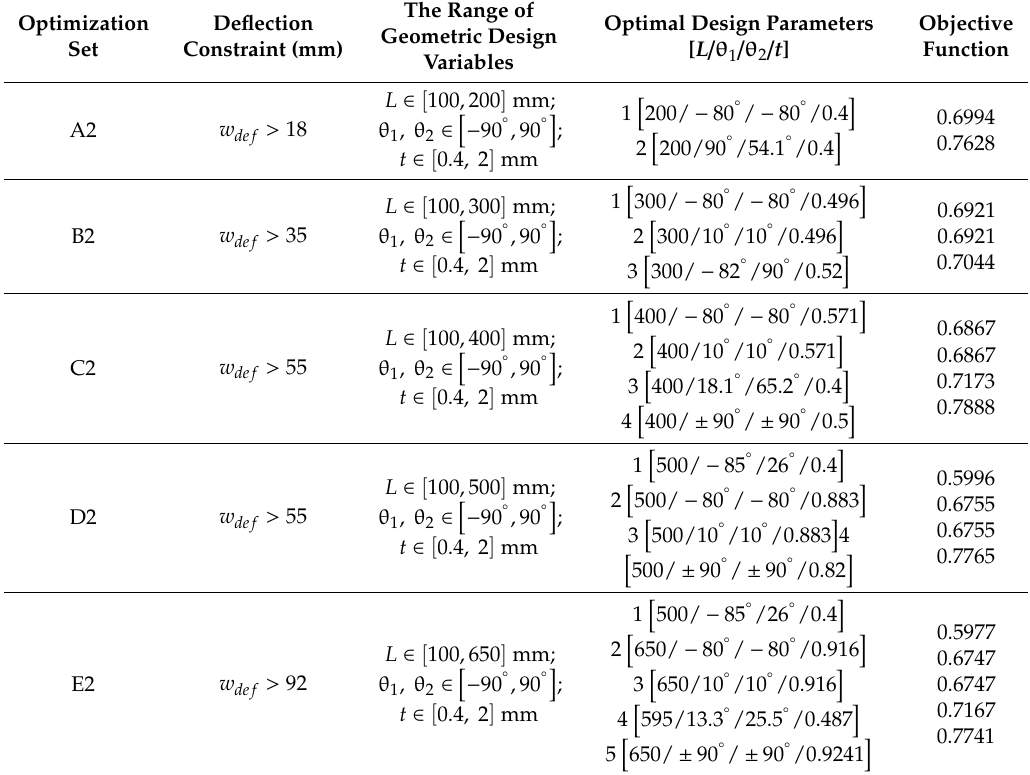
Table 5. Optimal design parameters for deflection constrained optimization with ϕ 1 = 75 ◦ , ϕ 2 = 0 ◦ .